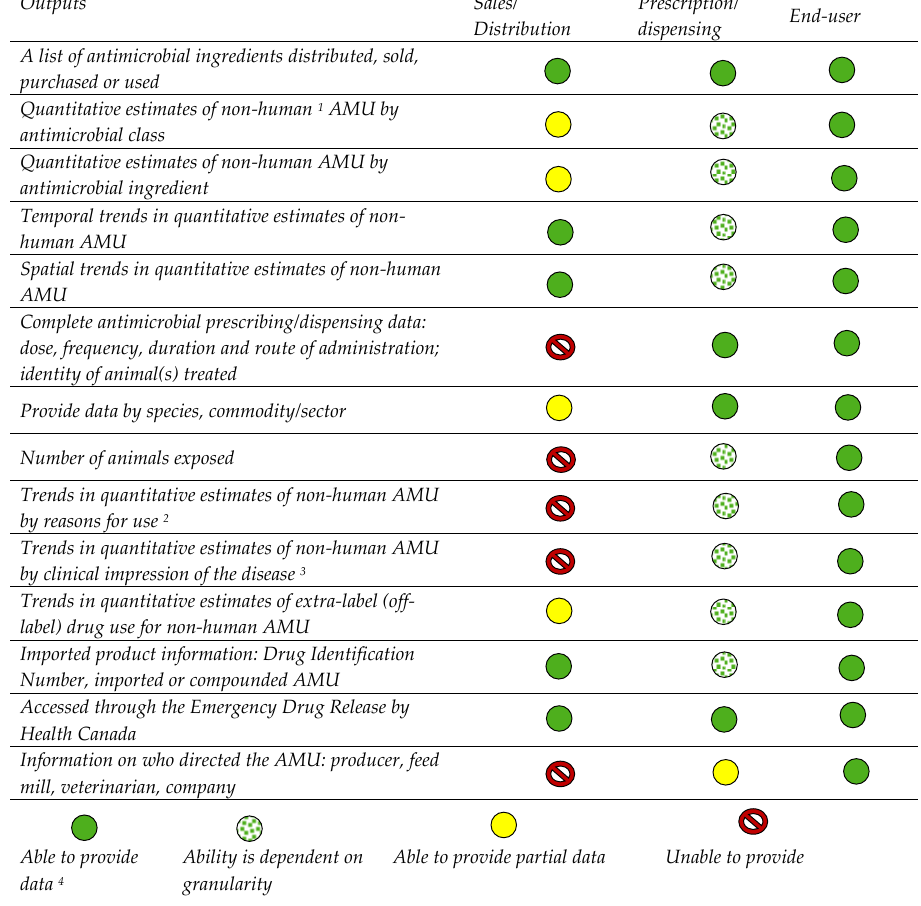
Figure 2. Antimicrobial use outputs from existing or future data collection points in the antimicrobial supply distribution pathway (figure modified from Reference [14]). 1 Nonhuman antimicrobial use in the table pertains only to animals. 2 Veterinary medical use such as disease treatment, control/metaphylaxis, prevention/prophylaxis, and additionally growth promotion. 3 Clinical impression by the veterinarian with input from producers and postmortem findings with or without laboratory diagnoses. 4 Ability to provide data (green circles) may be different for data collected in certain situations (i.e., confidential business information). AMU — antimicrobial use.